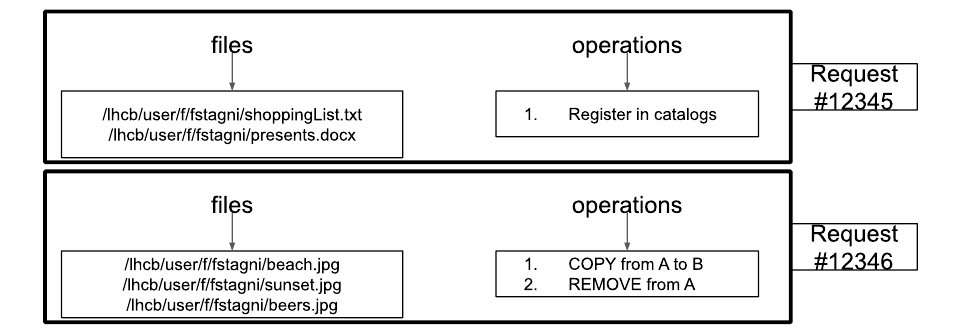
Figure 1. An example of two Requests in the RMS, each containing one or more operation , and one or more